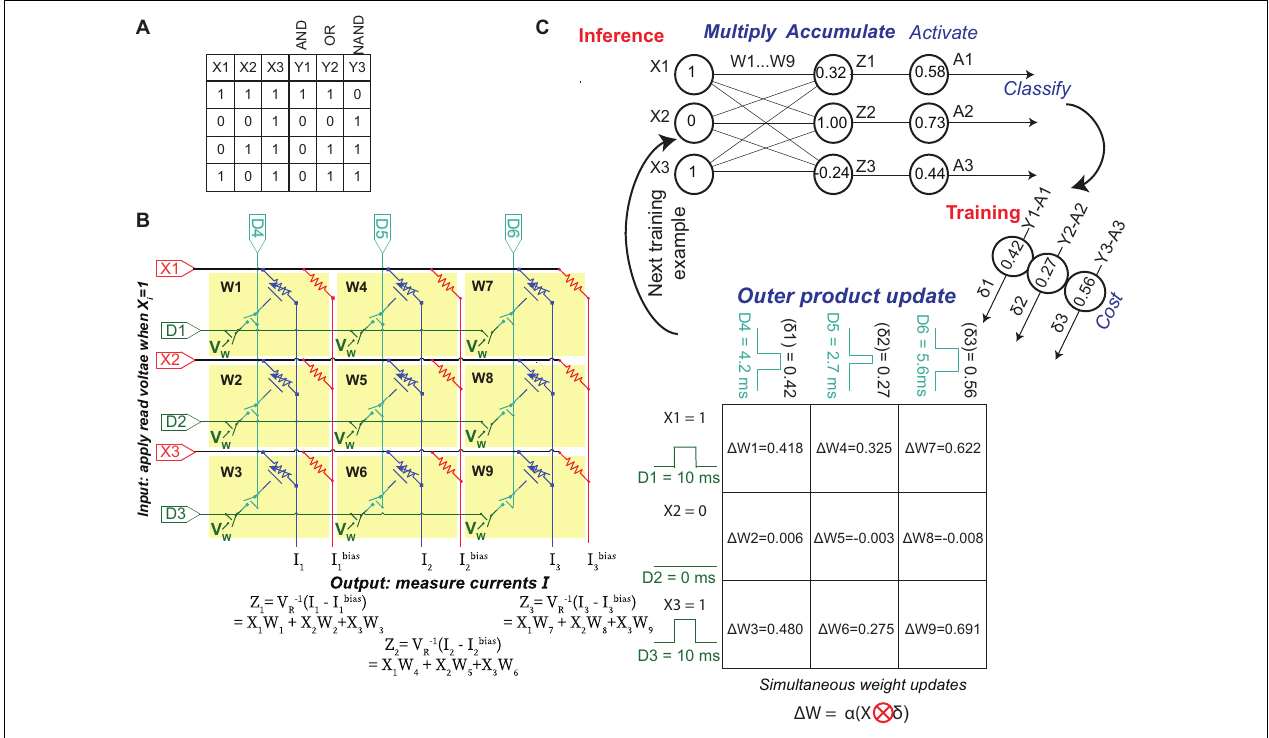
FIGURE 2 | Implementation of parallel array learning. (A) List of the training examples in this work. The “X” represents the inputs fed into the three rows of the crossbar, while the outputs “Y” show the correct solutions and used to compute the cost functions of each column output. (B) Circuit schematic of the nine-ECRAM array. Each synapse W 1 - 9 contains an element in Figure 1A ; the series resistor is not shown here for legibility. During inference, the circuit measures I-I bias using the subtractor circuit in Figure 1B , and this is converted to the non-dimensional software value Z. During weight updates, the digital inputs D 1 - 6 are used to select the time that the switches are ON in each row and column, which controls the change in weight for each device in accordance with an outer product update. (C) Flow diagram of learning process. During inference, multiply and accumulate are conducted using the crossbar in the manner described in (B) . Afterward, the activation energy and cost functions are computed in software and used to compute the weight update. To conduct a parallel outer product update, the pulse widths of digital switches D 1 - 3 correspond to the inputs X 1 - 3 , while the pulse widths of digital switches D 4 - 6 correspond to the cost δ 1 - 3 . Positive and negative weight changes must be conducted separately, so two steps are needed to conduct a parallel weight